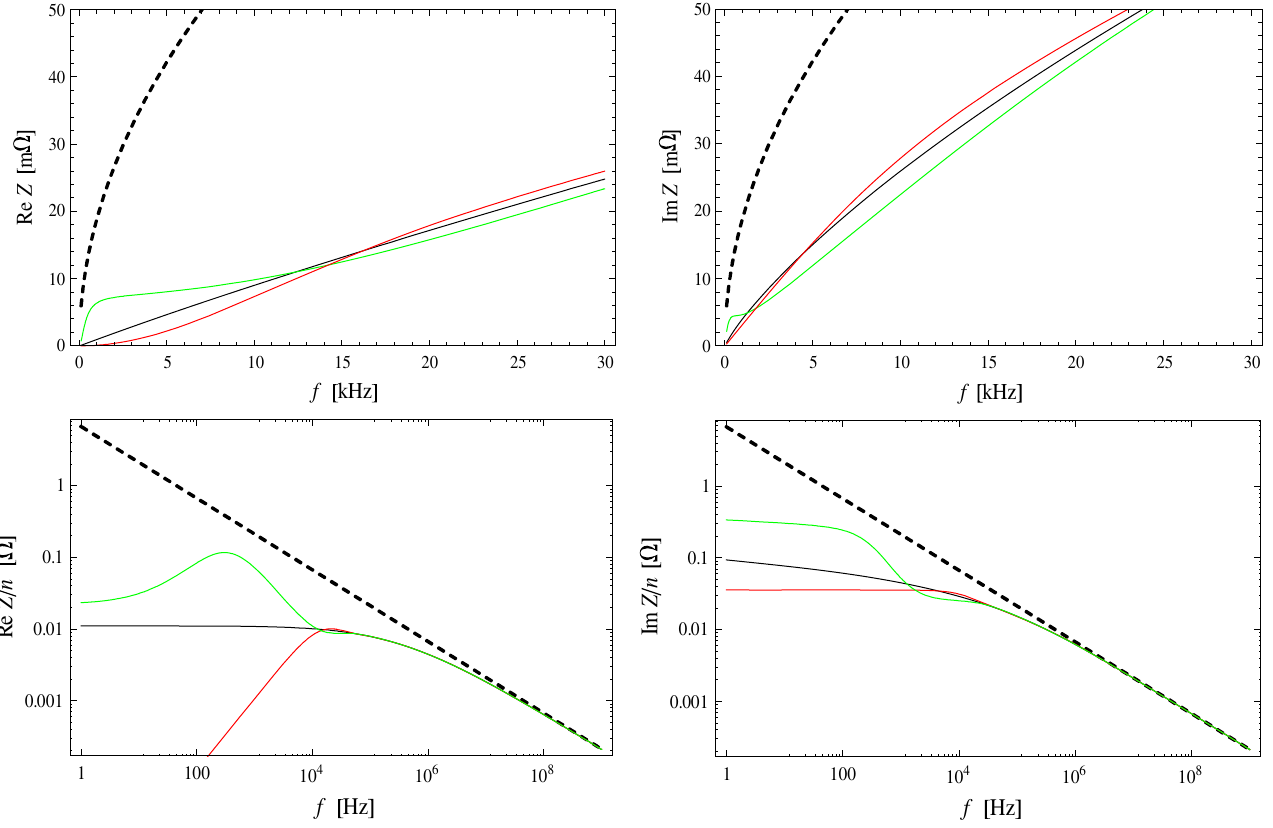
FIG. 4. Longitudinal coupling impedance of the LHC graphite collimator, 1 m long with radius b ¼ 2 mm and conductivity (cid:4) ¼ 7 (cid:1) 10 4 = (cid:3) m . The data are shown for the axial and radial model, respectively, in red and green. Also shown are the curves for the unbound thick layer from the exact (black) and from the approximate (dashed black)